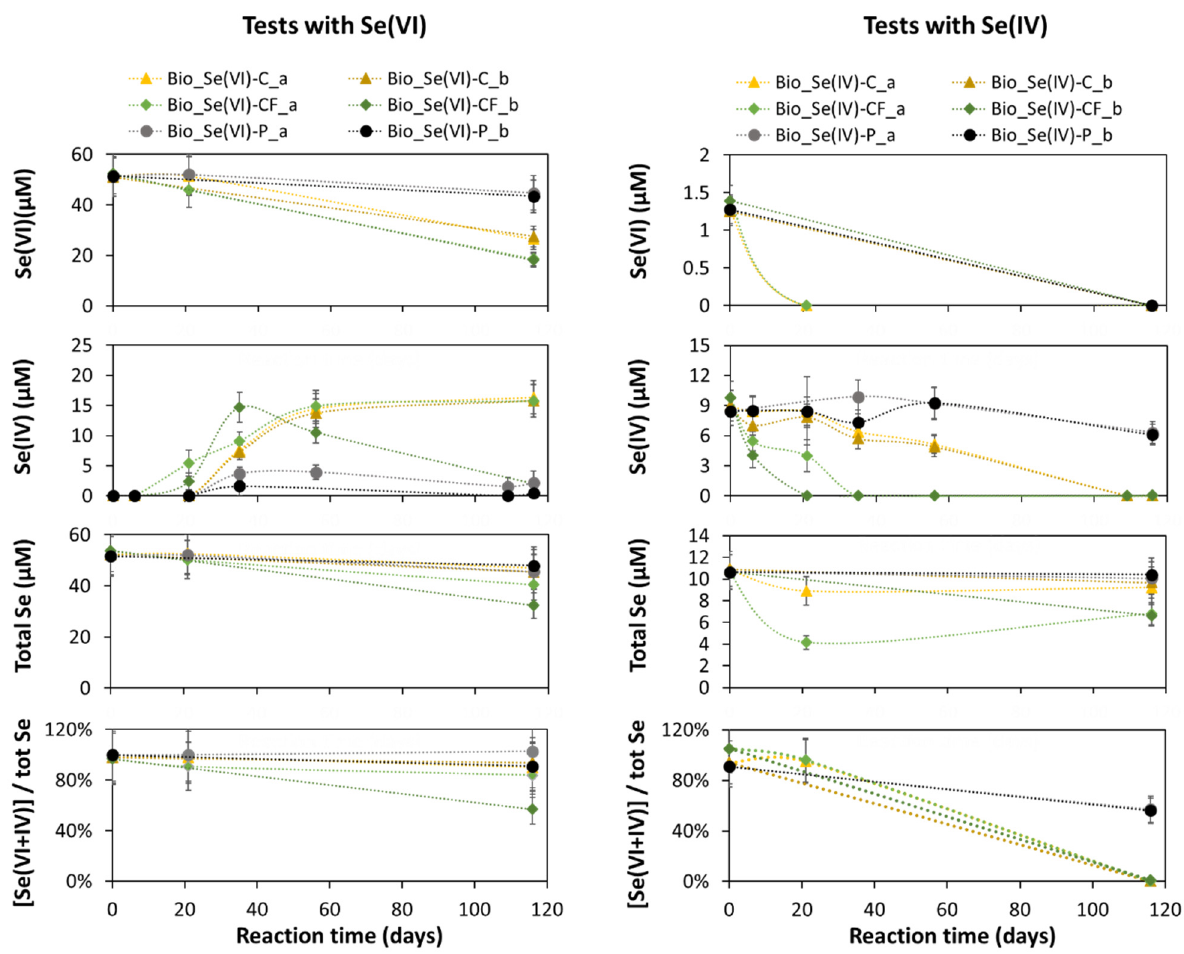
Figure 6. Biotic test results for Se(VI) (left) and Se(IV) (right) reactivity in the presence of Opalinus Clay (C) and/or stainless steel filter (F). Details on the test conditions can be found in the legend and in Table 2. The error bars represent the measurement uncertainty (95% confidence).